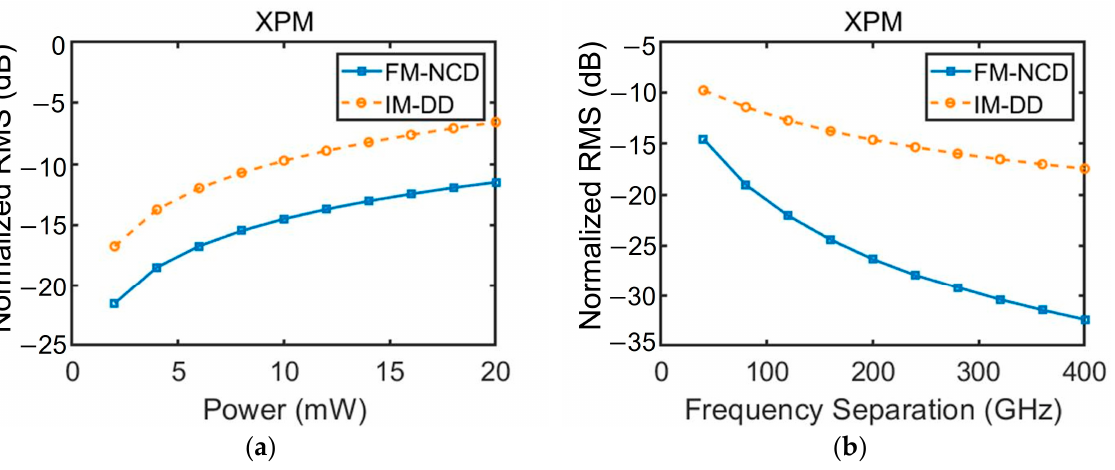
Figure 5. XPM-induced interference (normalized RMS) dependence on ( a ) optical power with a frequency separation of 40 GHz, and ( b ) frequency separation with the launched optical power of an interfering signal of 10 mW. The probe signal power launched into the fiber is maintained at 1 mW.